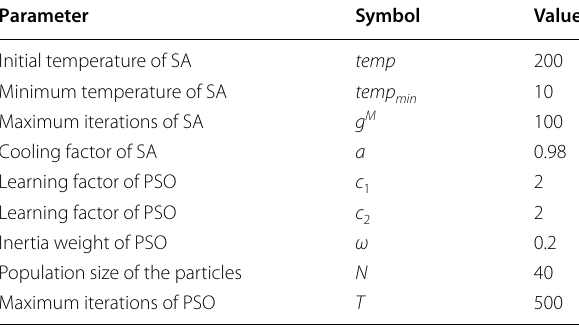
Table 2 Algorithm parameters of height control system